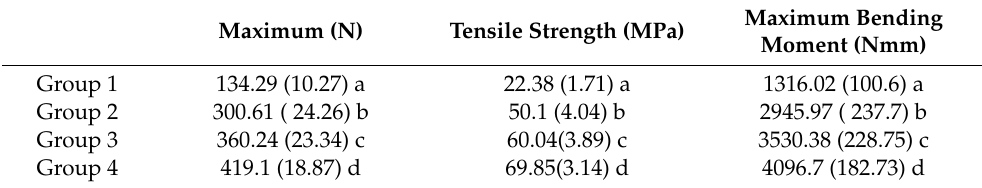
Table 1. Mean and standard deviation values for the maximum force, the tensile strength, and the maximum bending moment of each group. In the columns, di ff erent letters (a, b, c, d) indicate statistical di ff erence for the Tukey test ( p <